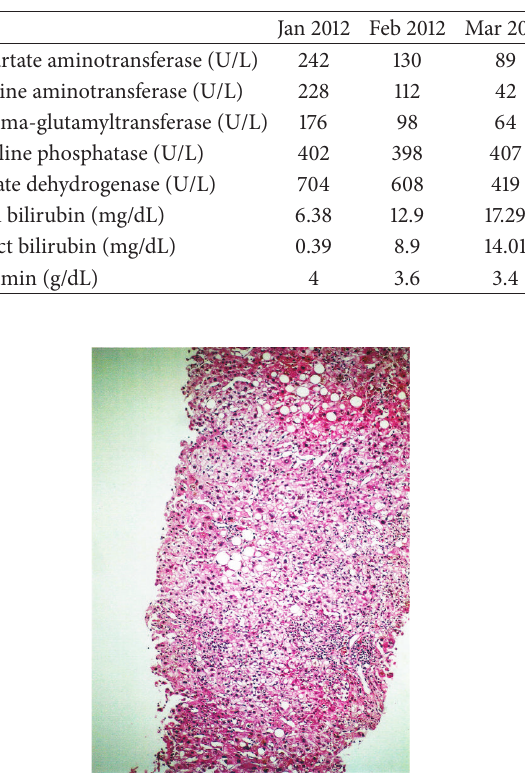
Table 1: Blood biochemistry findings for the parameters related to liver function.